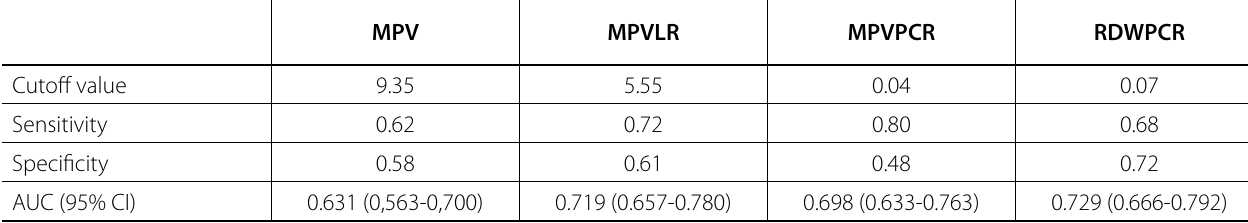
Table 3 . Cutoff values, sensitivity and specificity of MPV, MPVLR, MPVPCR and RDWPCR for predicting marker chronic inflammatory of ATAA.